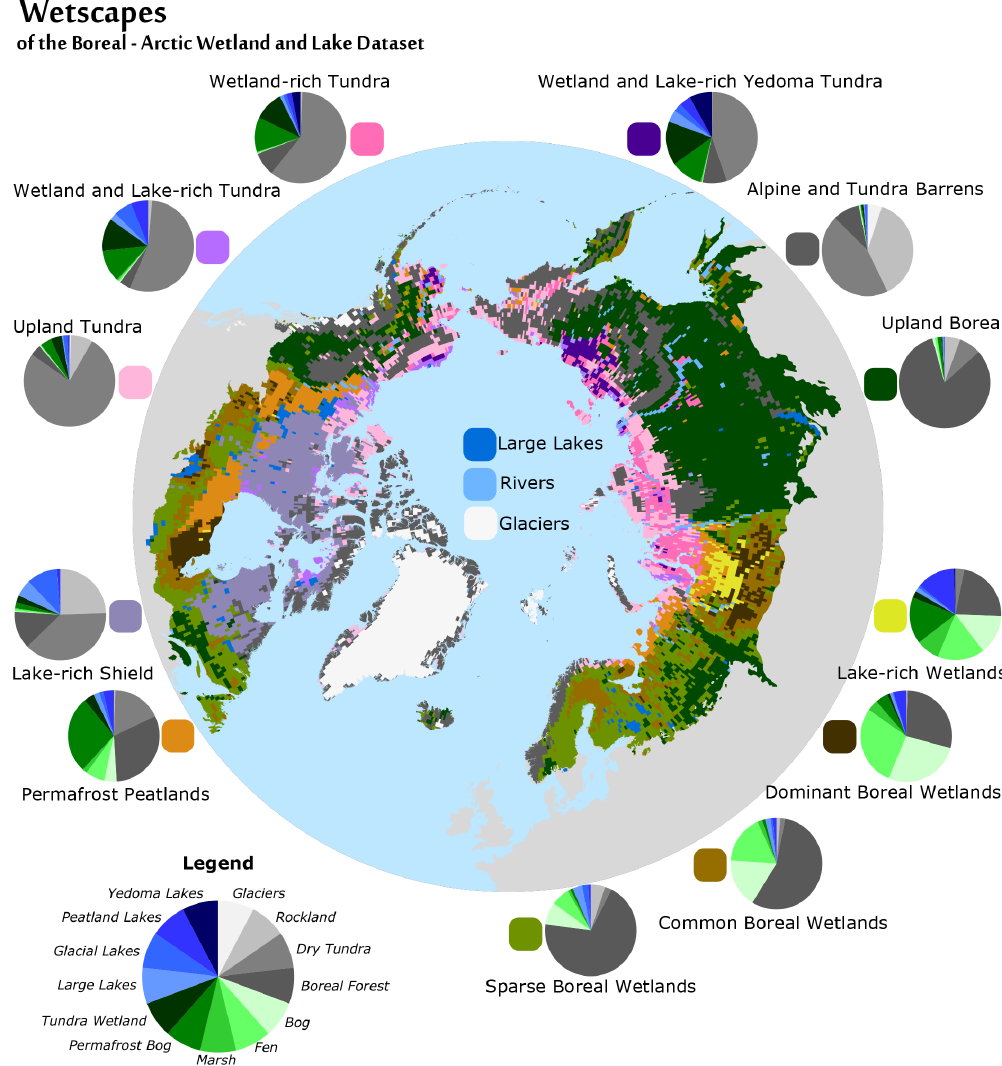
Figure 6. Wetscapes of the Boreal–Arctic Wetland and Lake Dataset. Wetscapes are defined by their characteristic composition of the BAWLD land cover classes and thus group regions with similar abundances (or absences) of specific wetland, lake, and river classes. The 15 wetscapes have their average land cover composition indicated by pie charts, with the legend shown in the bottom left. For clarity, the small and midsized lake classes were combined for glacial, peatland, and yedoma lakes, and the river classes were omitted from the pie charts. No land cover pie charts are shown for the Large Lakes, Rivers, and Glaciers